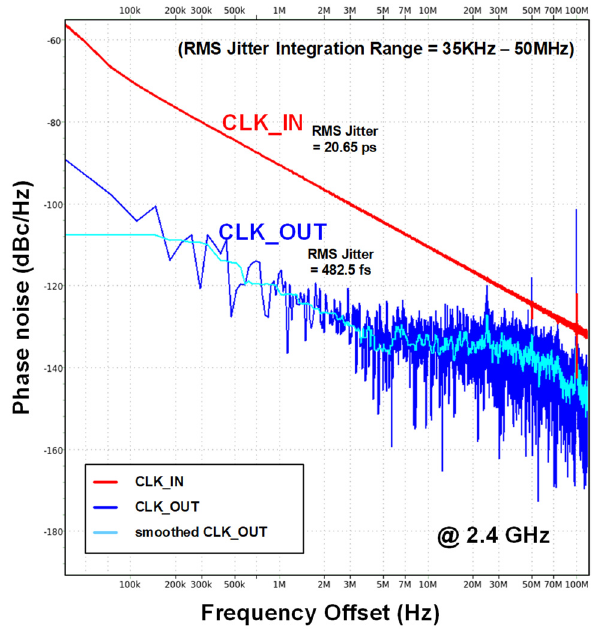
Figure 13. Post-layout-based phase noise simulation plots at 2.4 GHz output frequency. Table 2. Performance table of the proposed all-digital DJA.